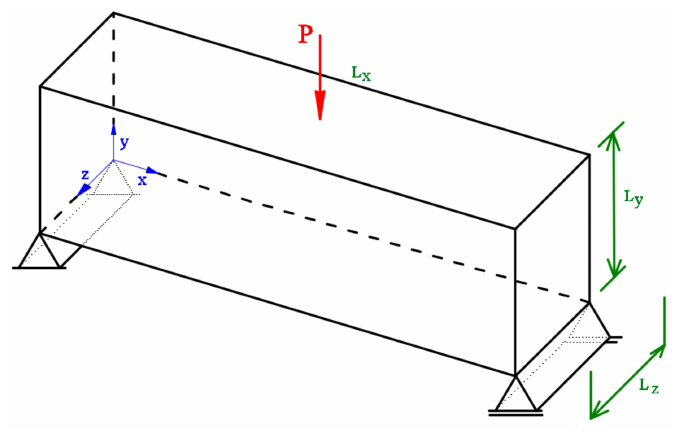
Figure 8. Design domain.